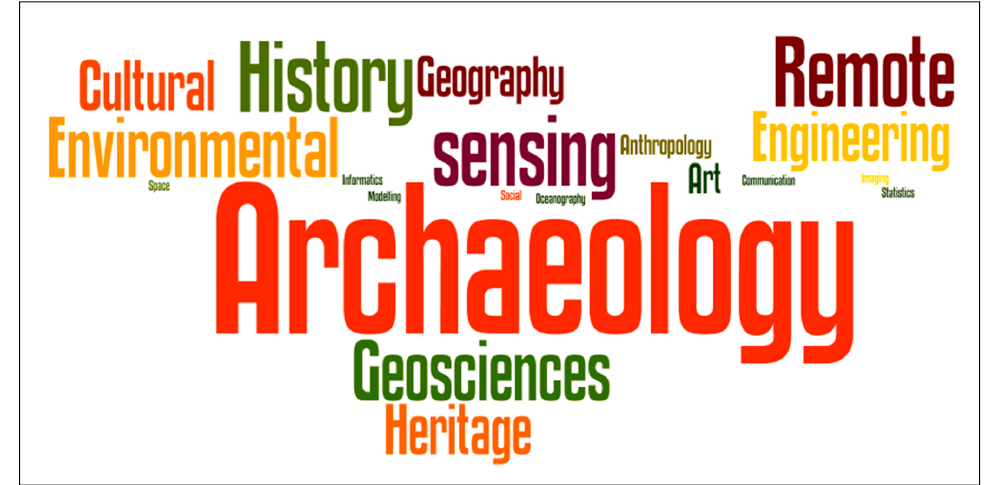
Figure 2. Word cloud of the disciplines and scientific domains the authors publishing in this Special Issue belong to [9–29], as inferred from their affiliations.